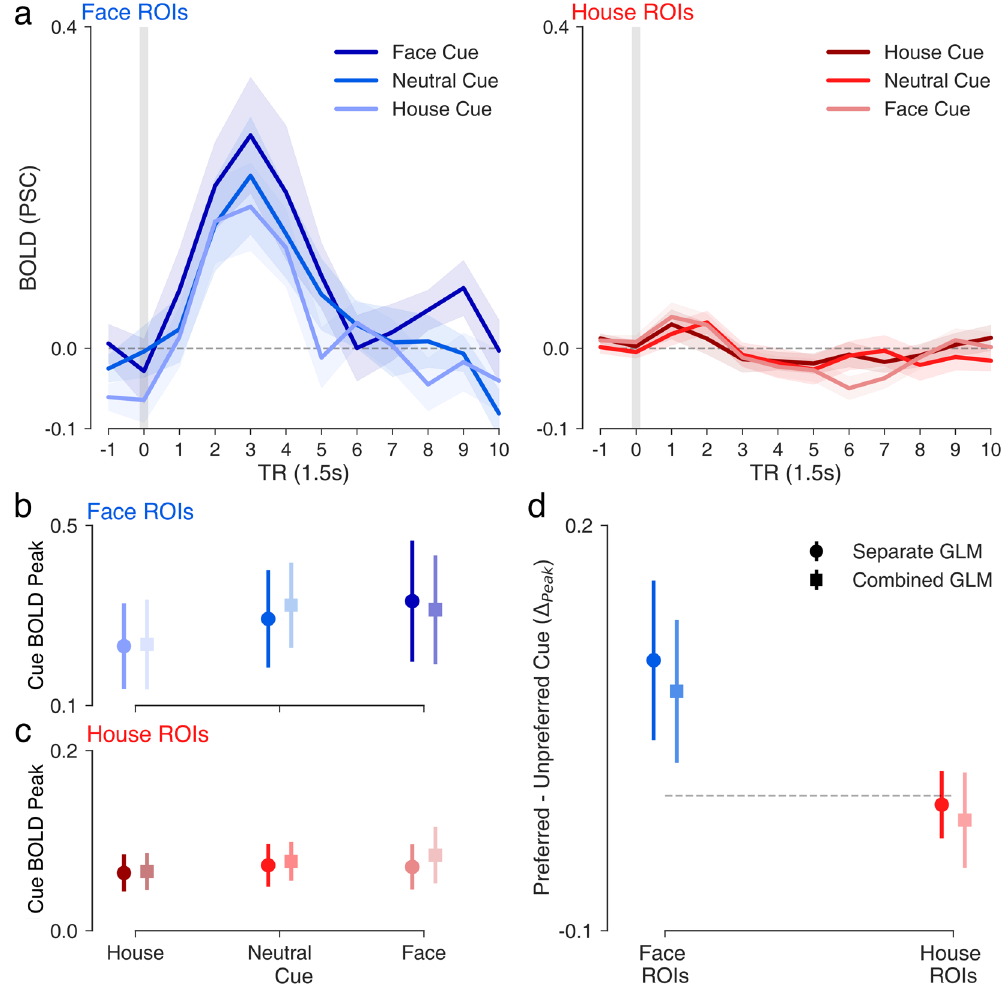
and house (red, right) ROIs time-locked to 1 TR before cue onset, estimated from from catch trials and full trials in the separate events GLM. Peak magnitude of activity plotted for each cue type in ( b ) face and ( c ) house ROIs based on estimates from the separate events GLM (circle markers; darker colors) and combined events GLM (square markers; lighter colors). ( d ) Peak difference in cue-evoked activity for region-preferred cues versus non- preferred cues in face (blue) and house (red) ROIs. Shaded area around mean timecourses reflect + / − 1 s.e.m. Error bars in point plots reflect 95% c.i. around the